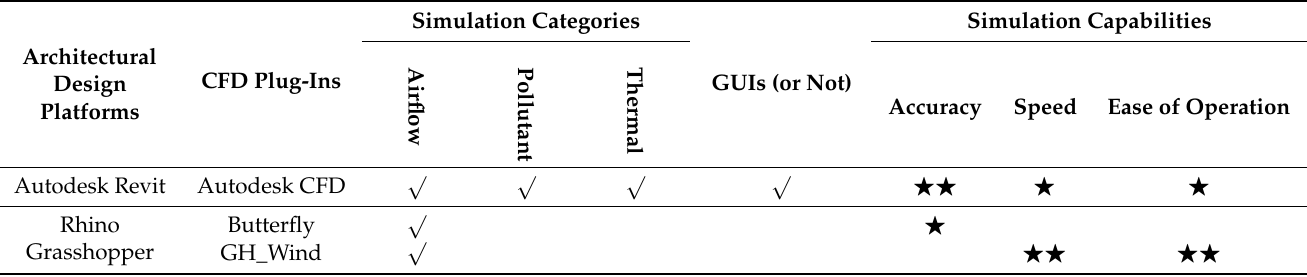
Table 6. Comparison of CFD plug-ins integrated into architectural design